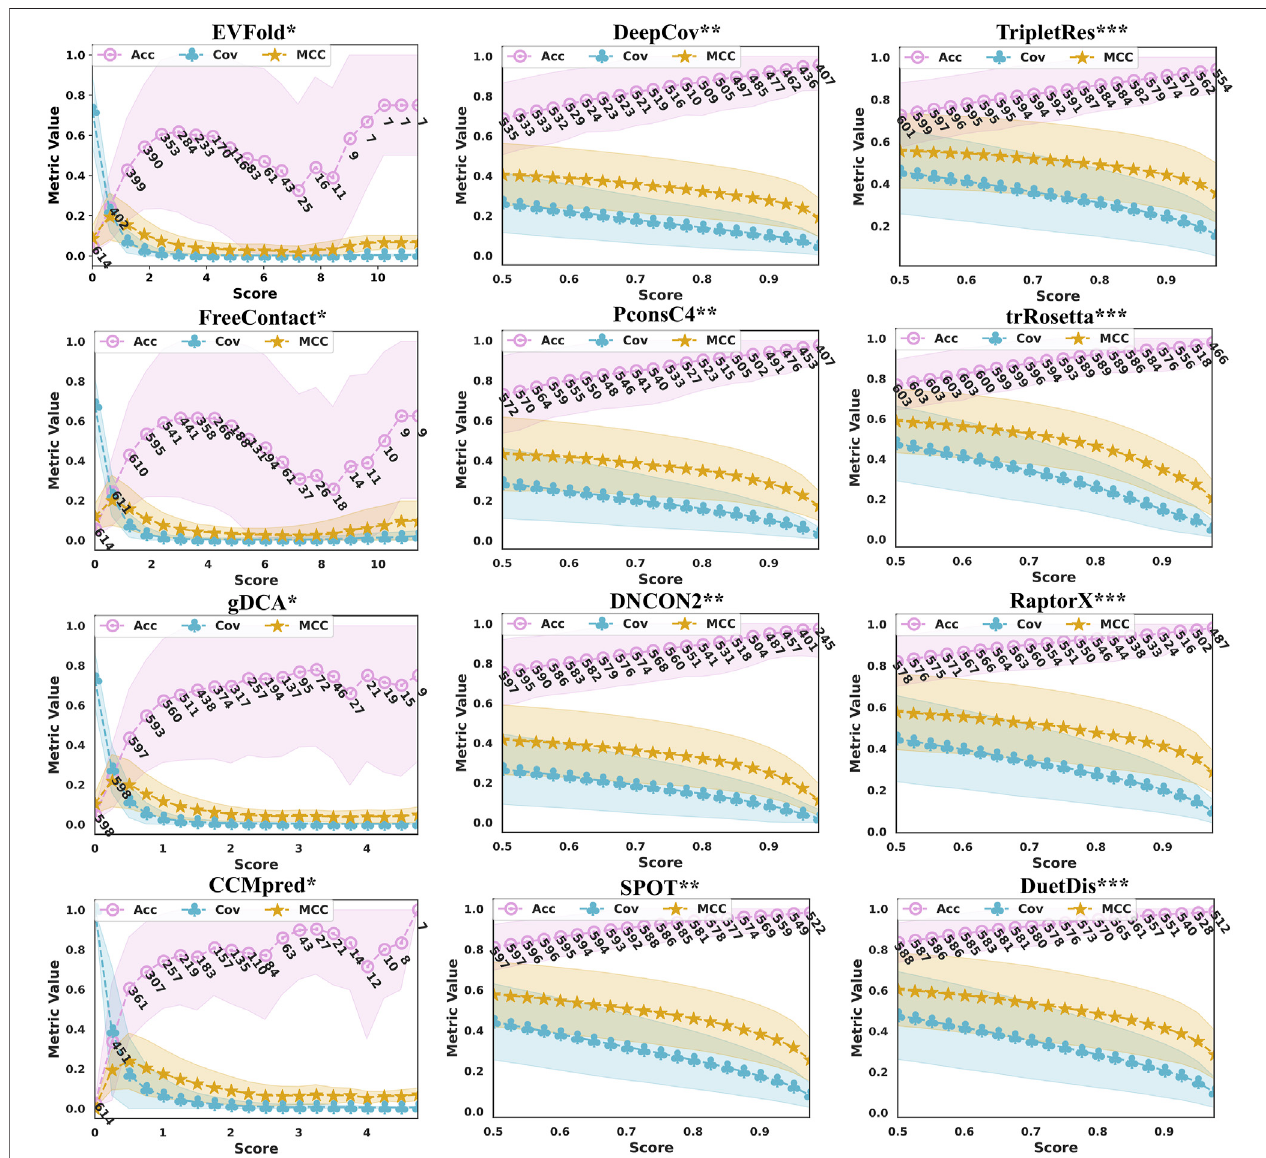
FIGURE5| Predictionperformanceinterms ofprecision,coverage,MCC, andthecorrespondingstandarddeviation(theshaded areaaroundthecurves) withthe increasingprobability(score)thresholdgivenbythepredictors.Thenumbersundertheprecisioncurve(blue)arethenumbersofproteinswithpredictionsreturnedusing the corresponding (score) threshold on the